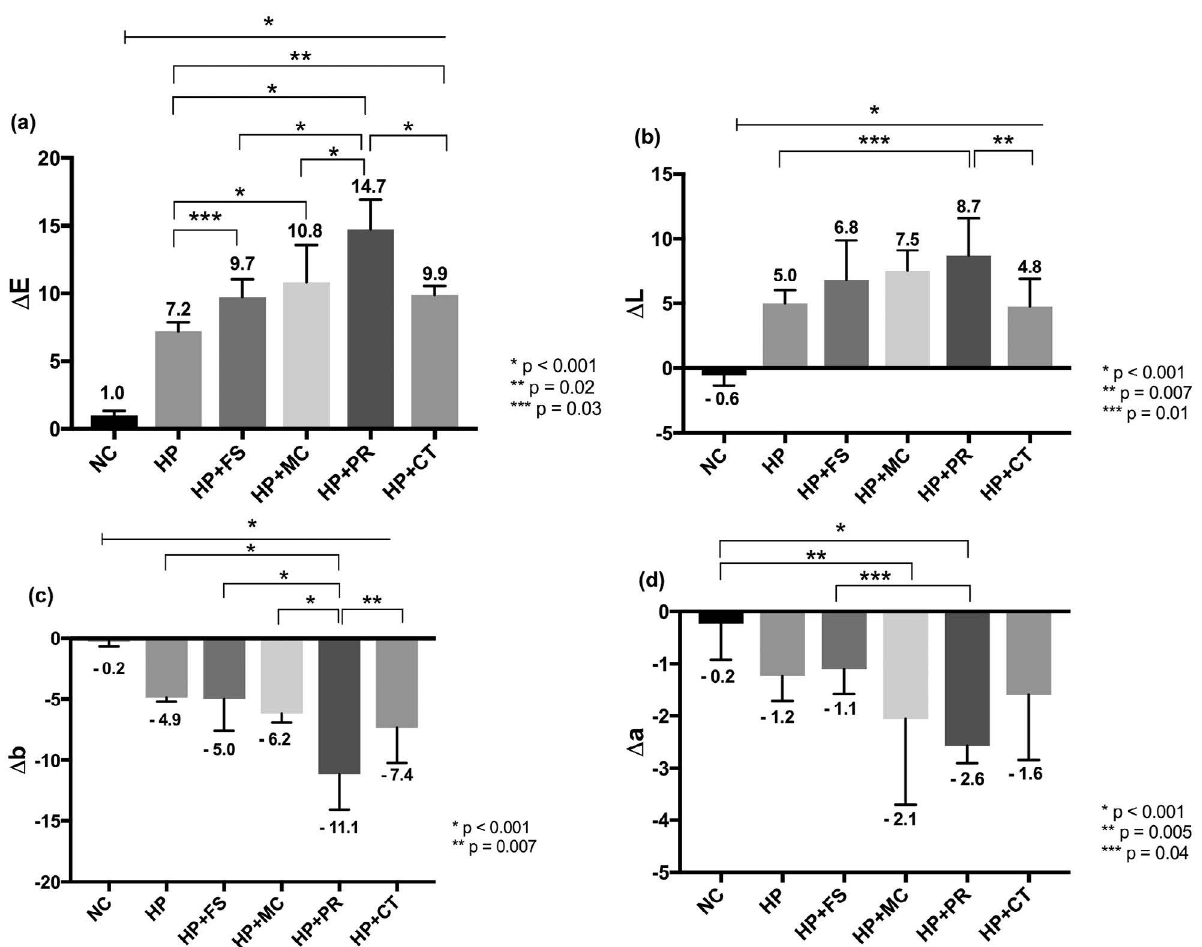
Figure 3- (a), (b), (c) and (d) Bar graph of mean (standard deviation) of D E, D L, D b, and D a values, respectively, for color alteration assay (CIE L*a*b*). Numbers are mean delta for each group.